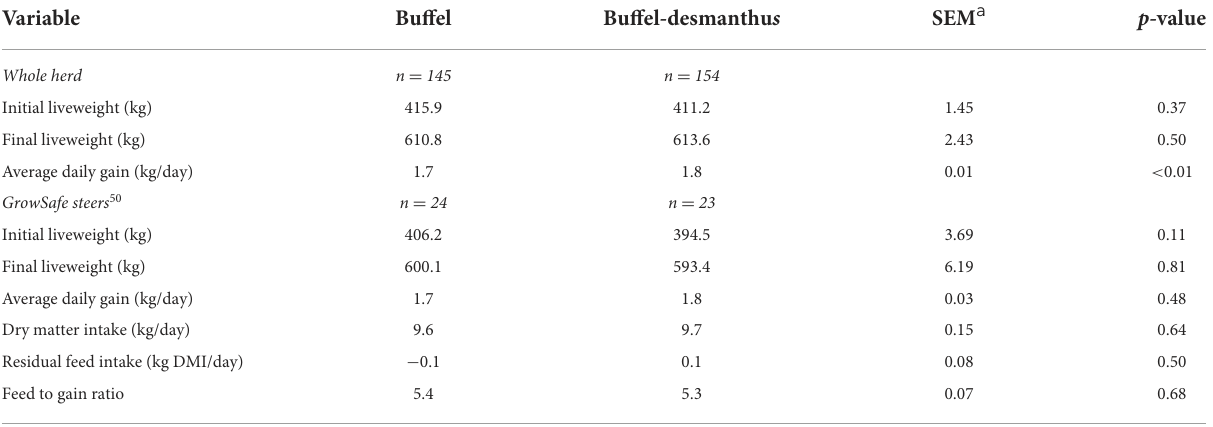
TABLE 3 Mean feedlot growth performance and feed intake. Variable